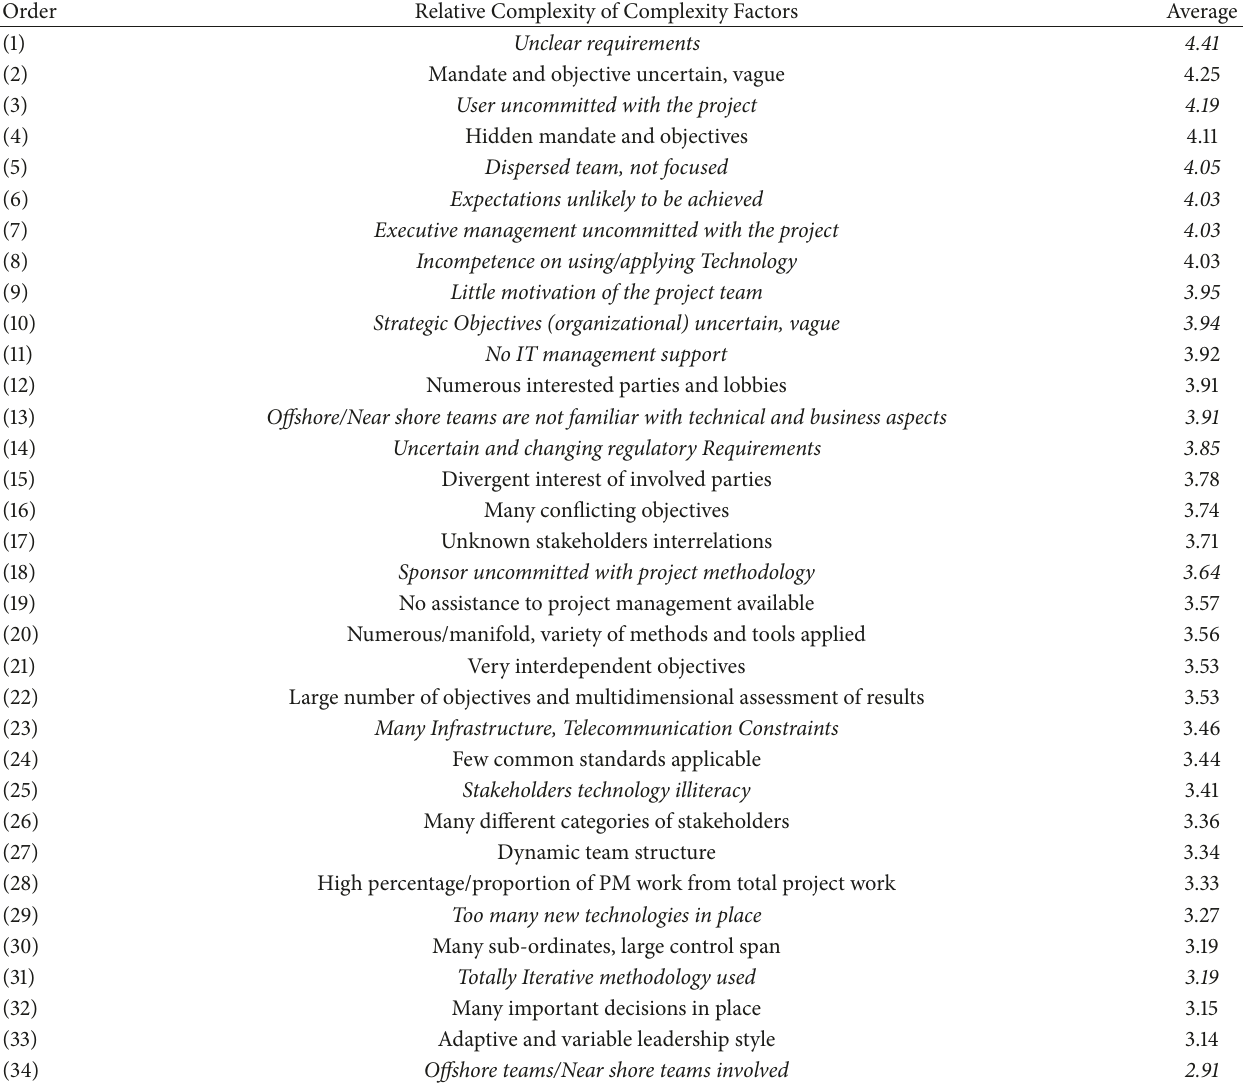
Table 7: Summary of Questions related to complexity factors within each